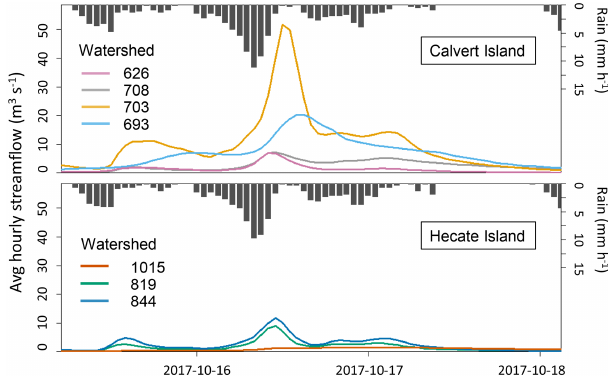
Figure 5. Hydro-hyetographs for the seven gauged watersheds dur- ing a large storm event (114mm of rain in 3d). Rain measurements at SSN708 and SSN819 are